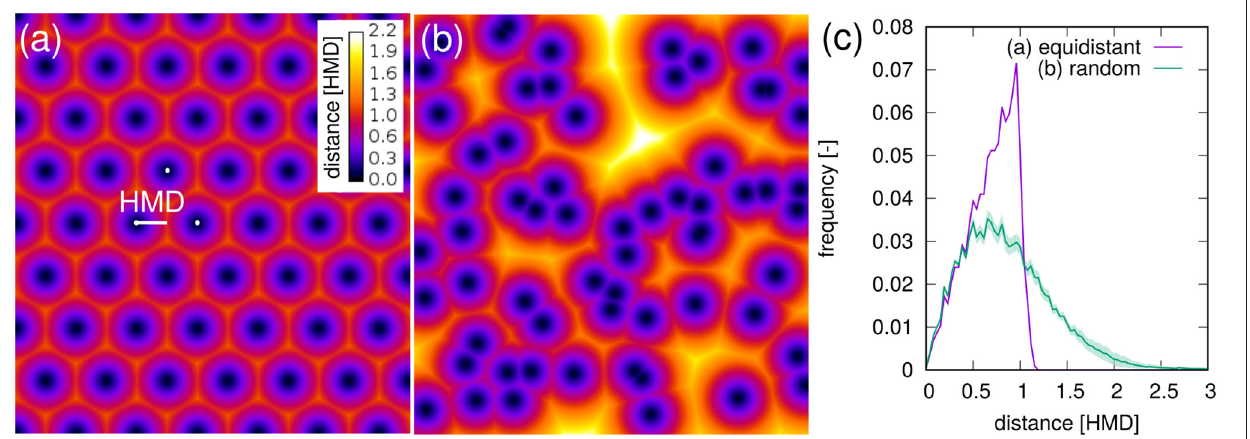
FIGURE 8 | Root-soil distances in (a) an equidistant, hexagonal root bundle and (b) for a random pattern of roots in a two-dimensional cross section. The distances are normalized by the half-mean distance between roots. The root length density is the same in both point patterns. (C) The root distance histograms for both point patterns. Shaded areas for random point patterns represent standard deviation of ten realizations.